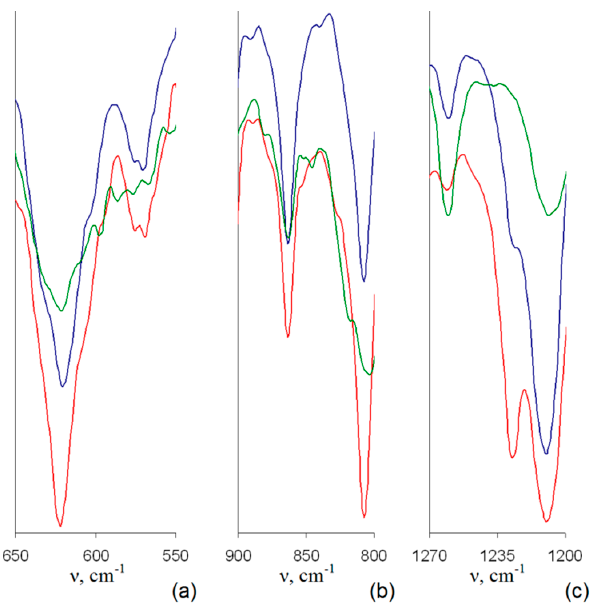
Figure 5. Normalized IR spectra of the samples: 4 (blue line), 5 (red line), and 6 (green line) in the range of 650–550 cm − 1 ( a ), 900–800 cm − 1 ( b ) and 1270–1200 cm − 1 ( c ).